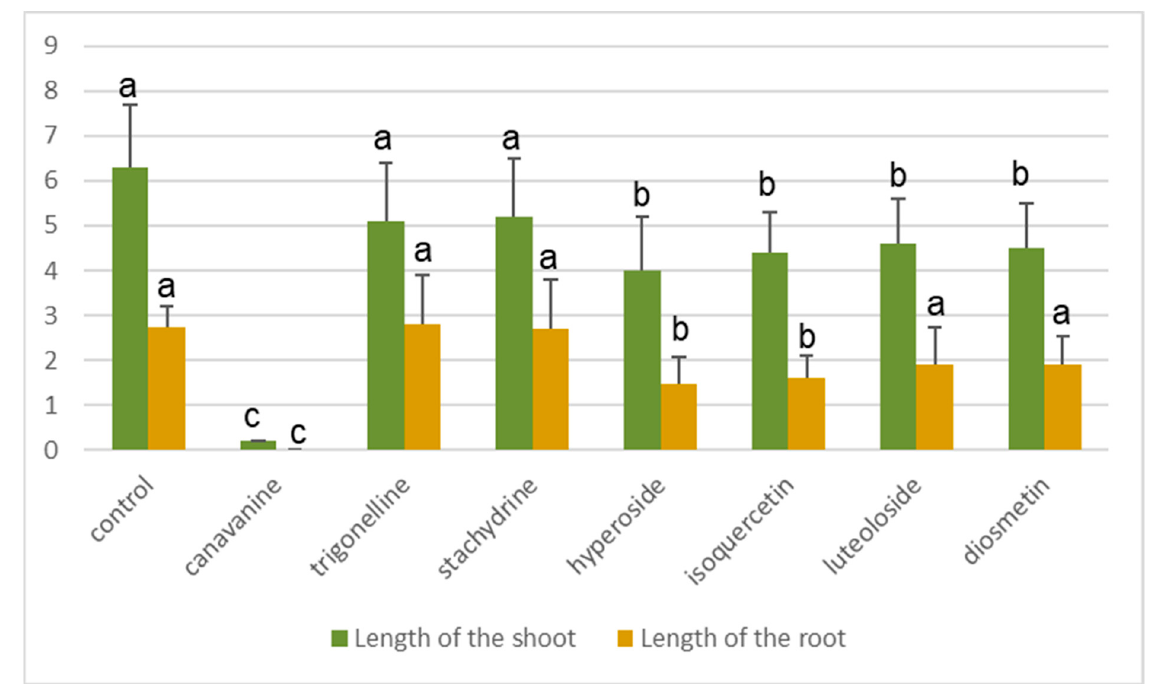
Figure 5. Lengths of the shoots and roots of barley seedlings after treatment with the pure main components of the alfalfa seed exudates after 10 days at a concentration of 150 µg/mL (except for luteoloside, which was employed at 20 µg/mL). Different lowercase letters on the top of the column for each treatment indicate significant differences with p < 0.05 using Tukey’s test. The mean value corresponds to the average value of forty seedlings. The error bar corresponds to the standard de- viation.